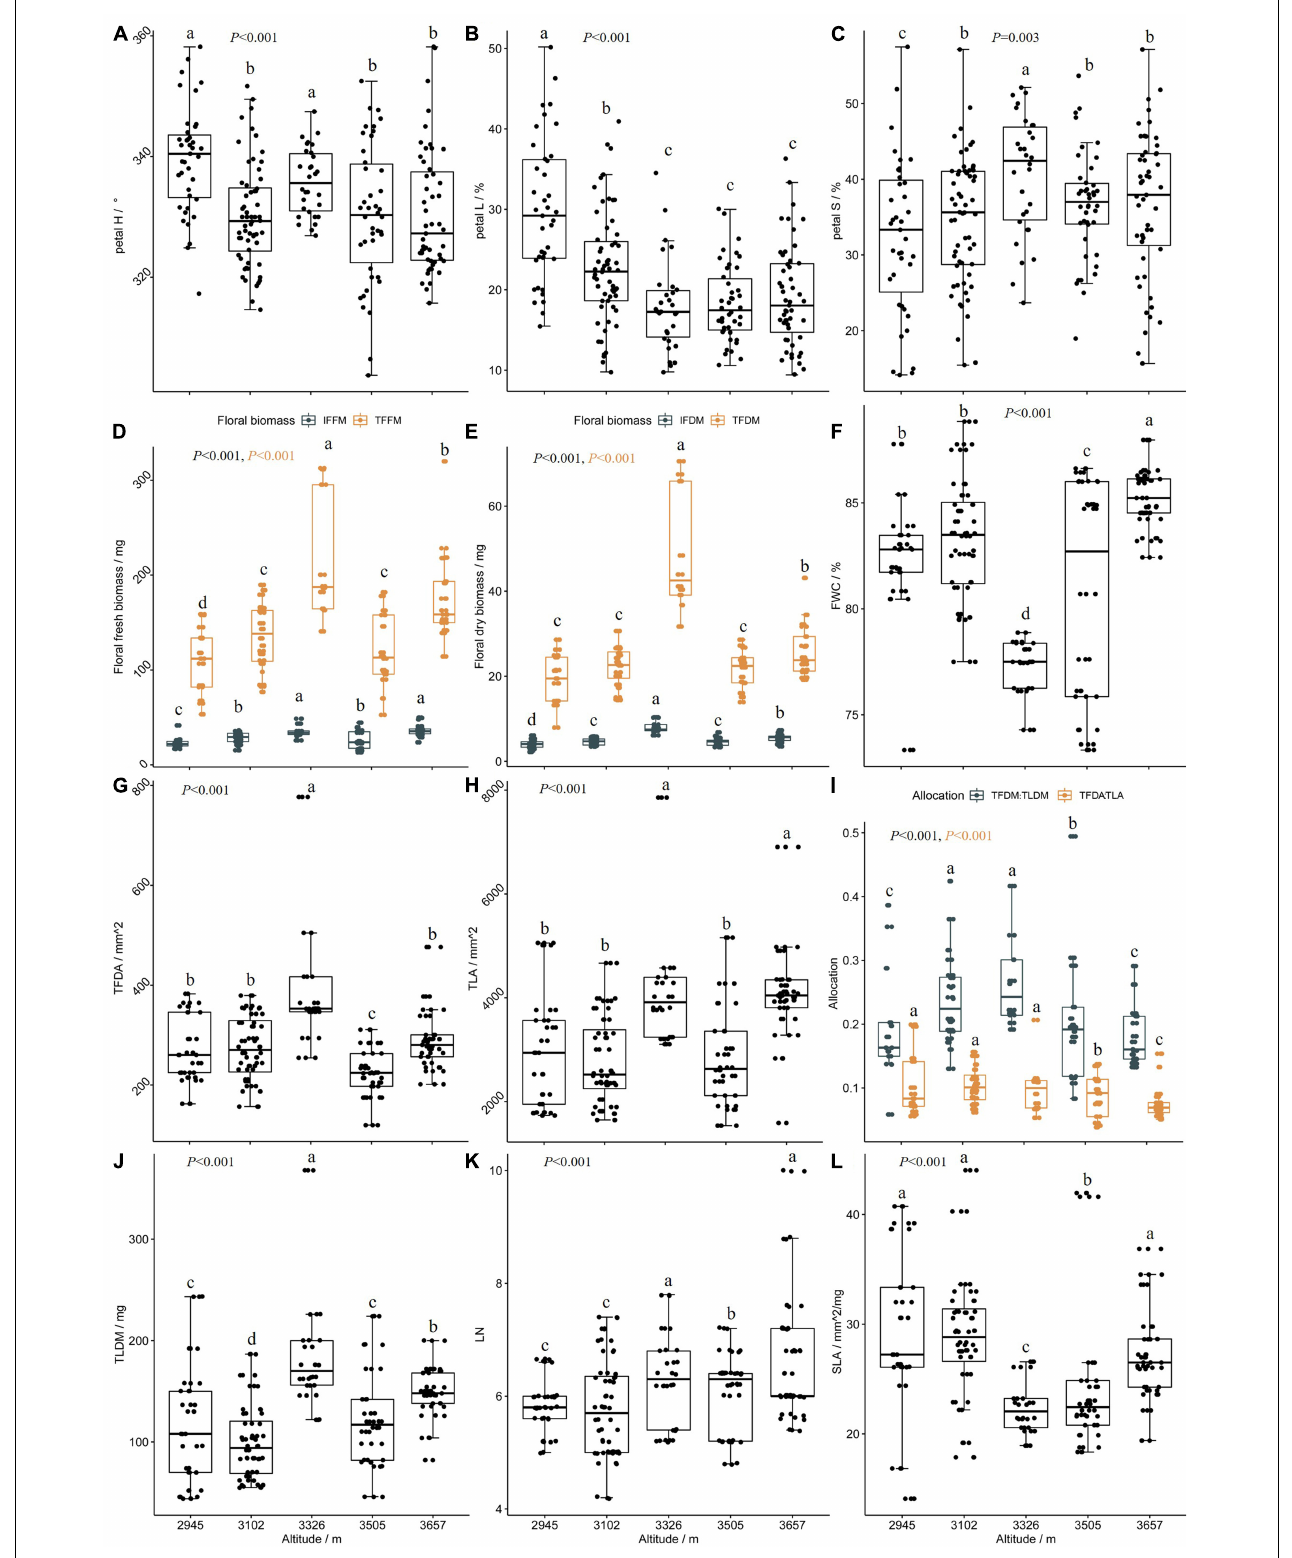
FIGURE 3 | (A–L) The altitude has respective effects on floral color, floral display, leaf traits, and biomass allocation.